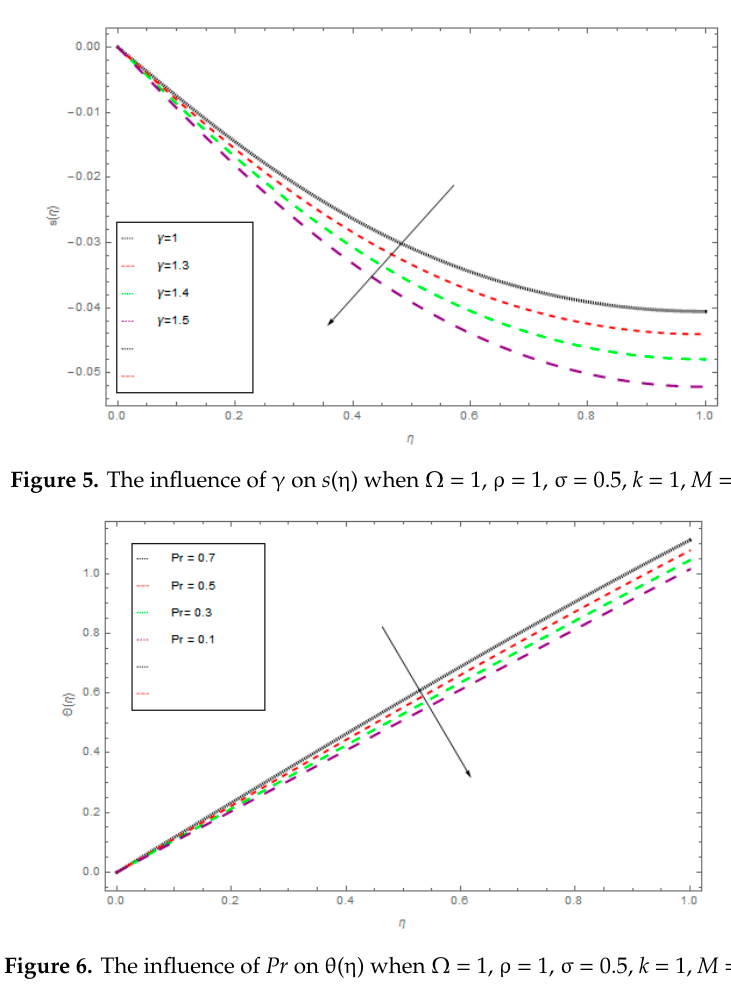
Figure 4. The influence of γ on k ( η ) when Ω = 1, ρ = 1, σ = 0.5, k = 1, M = 1.